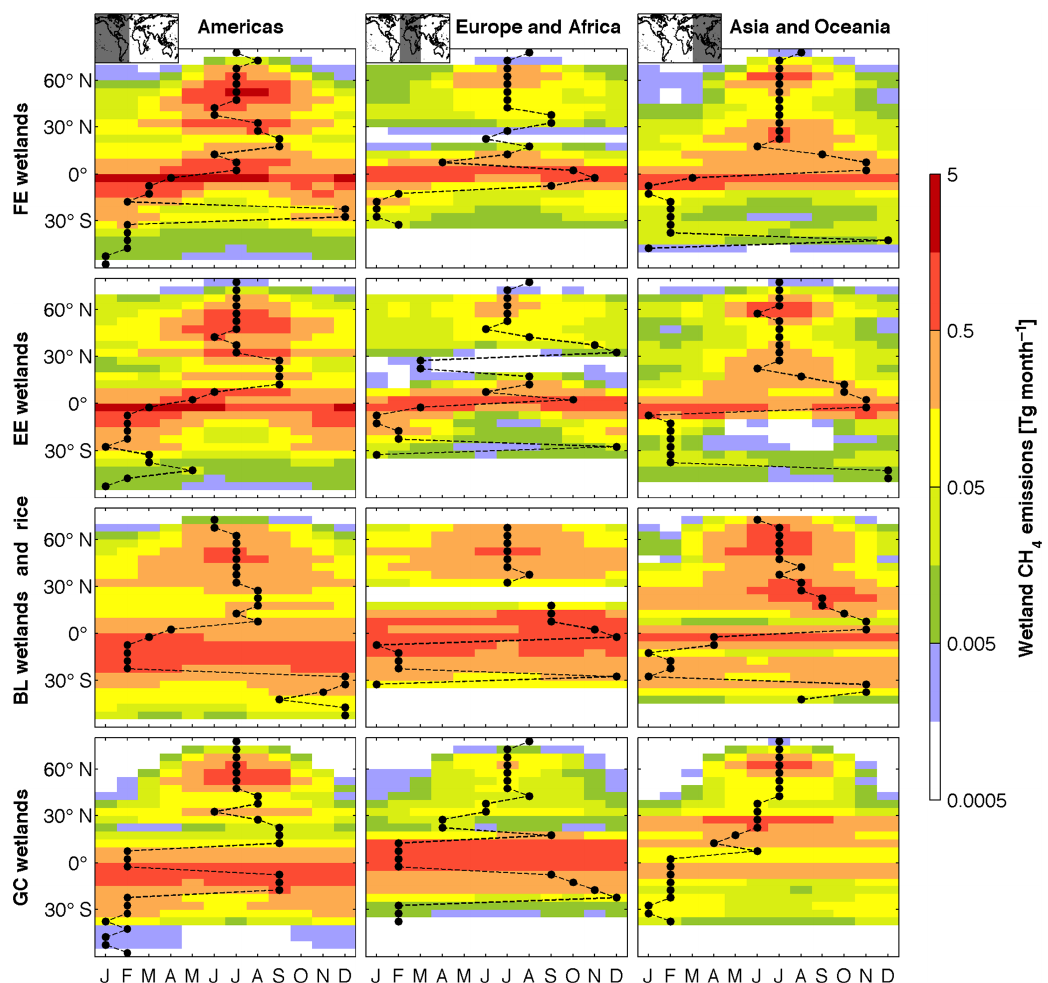
Figure 3. Seasonally averaged 2009–2010 wetland CH 4 emissions for this study (full ensemble: FE; extended ensemble: EE), Bloom et al. (2012) wetland emissions (BL) and GEOS-Chem wetland emissions inventory (GC) across North and South America (left column; 180– 35 ◦ W), Europe and Africa (centre column; 35 ◦ W–55 ◦ E) and Asia and Oceania (right column; 55–180 ◦ E). The emissions for each region are reported as total monthly fluxes across 5 ◦ latitude bins. The black dotted line denotes the maximum emission month within each 5 ◦ latitude